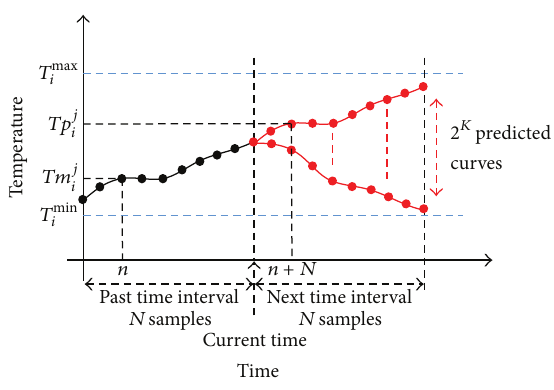
Figure 4: Prediction of temperature, a fundamental step of the energy scheduler to assess comfort in the future time